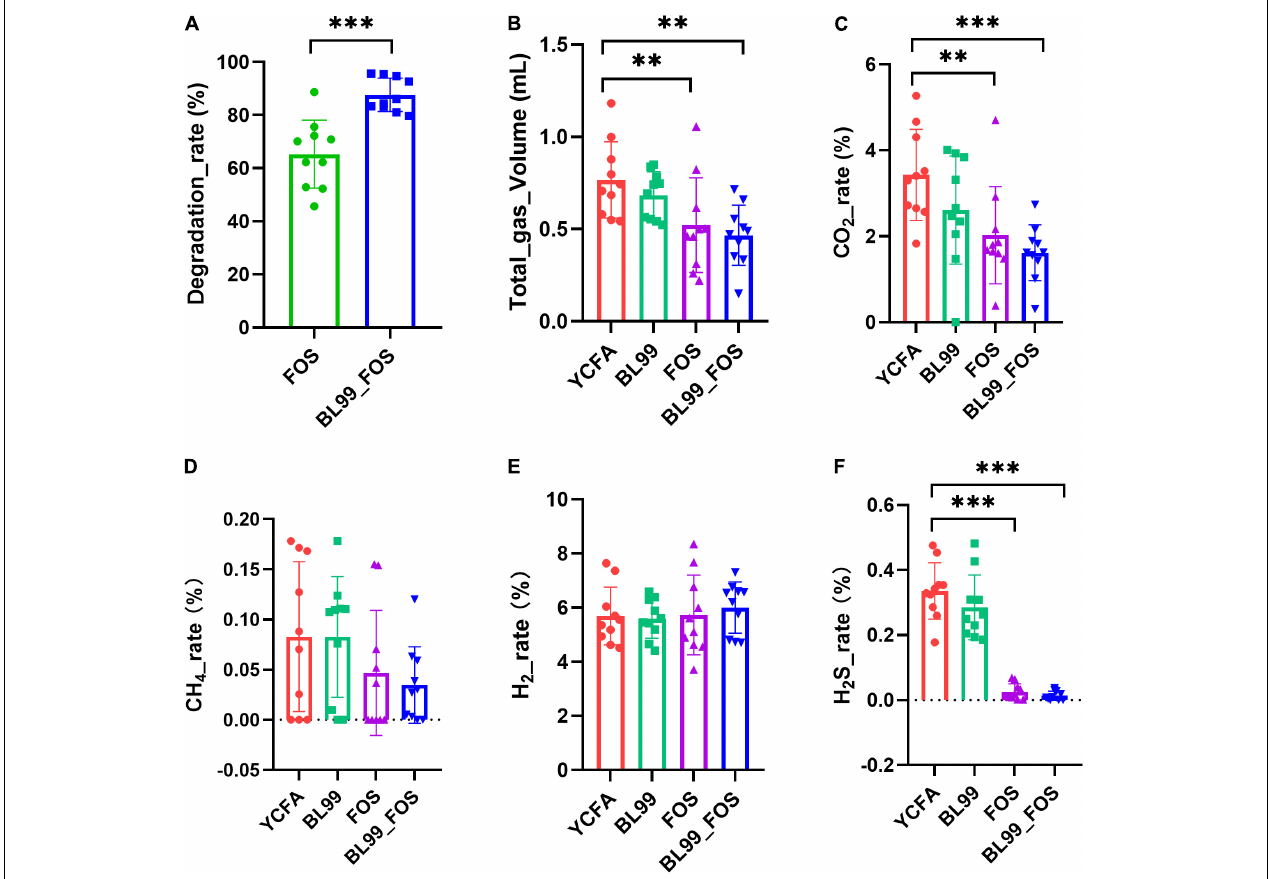
FIGURE 1 | FOS degradation rate (A) , total gas production (B) , and gas production ratio (CO 2 (C) , CH 4 (D) , H 2 (E) , and H 2 S (F) in various groups. Statistical significance was calculated by one-way ANOVA with LSD test, * was used to mark the significance between different groups, and no mark means there is no